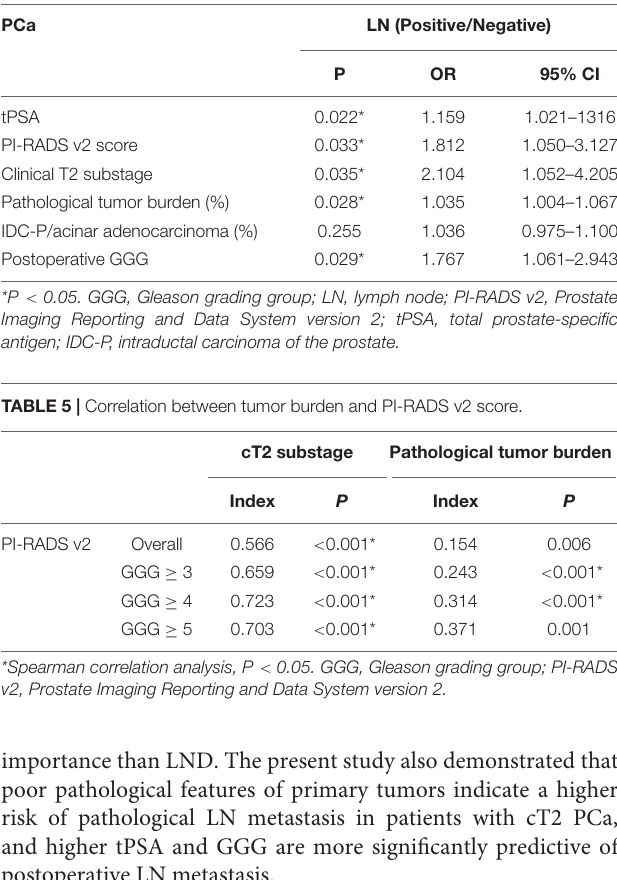
TABLE 4 | Multivariate logistic regression analysis of risk factors for LN invasion in patients with GGG ≥ 3.